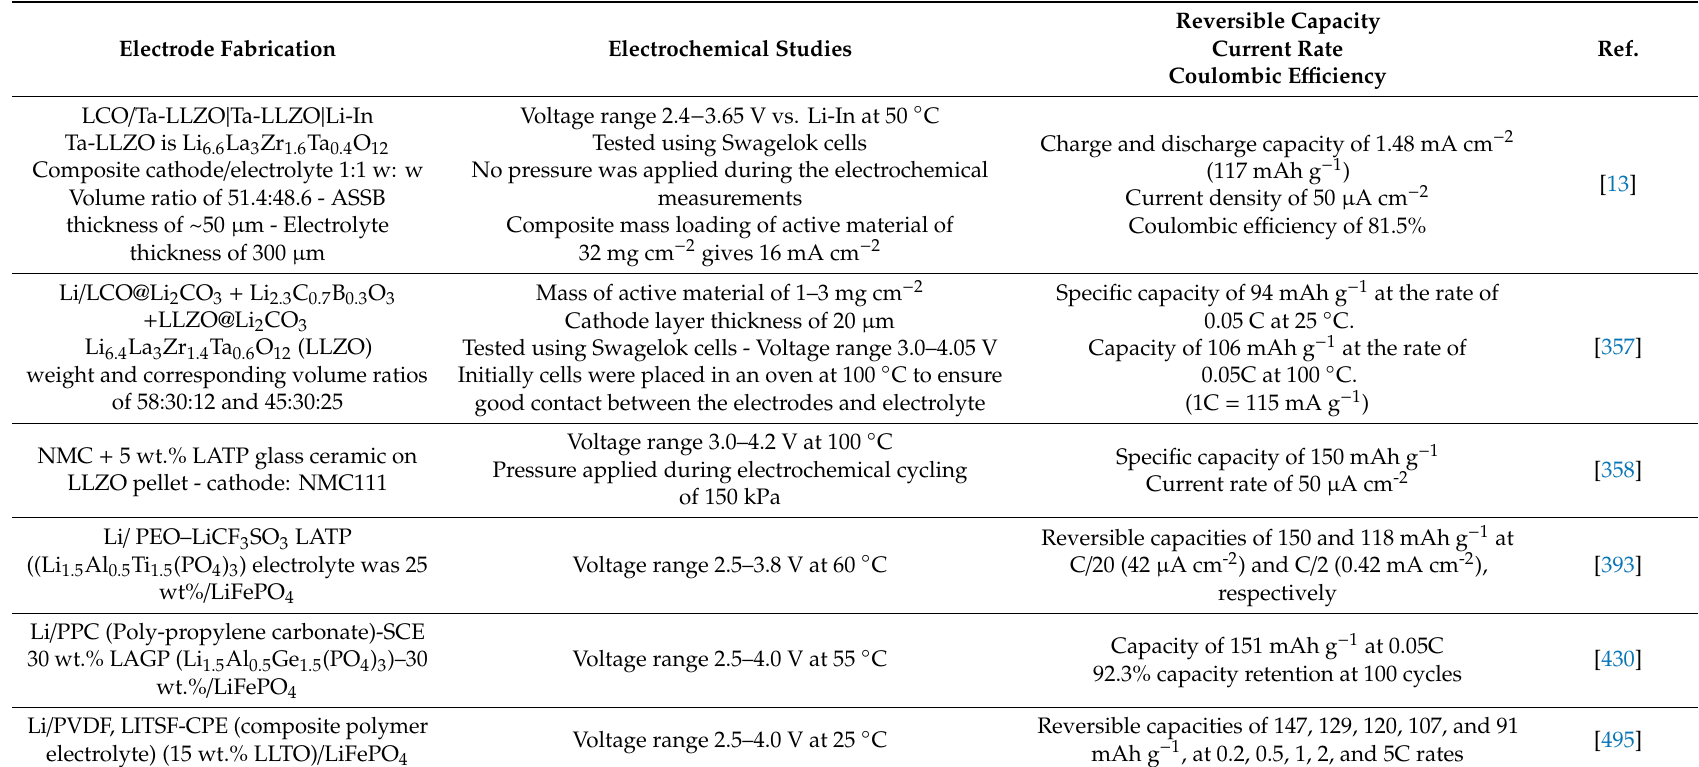
Table 4. Electrochemical performance of oxide solid electrolytes for all-solid-state